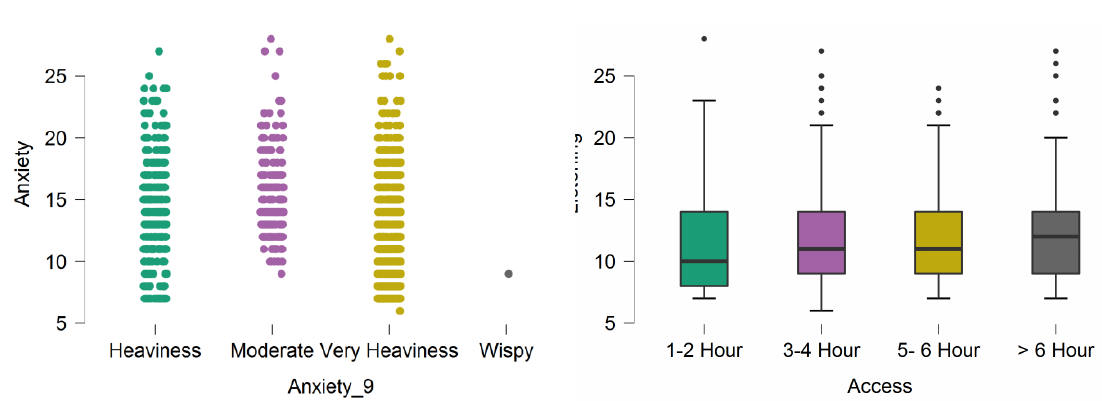
Figure 1. Anxiety Based on Category Figure 2. Listening Aspect